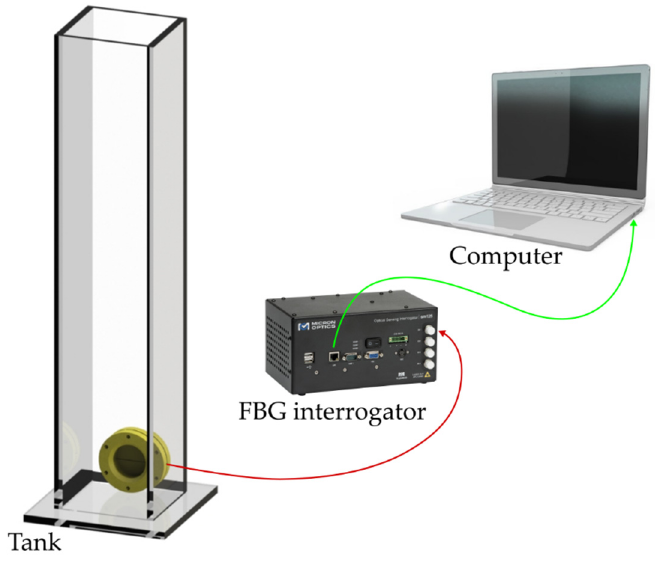
Figure 3. Schematic representation of the experimental setup used for liquid level test characteriza- tions.